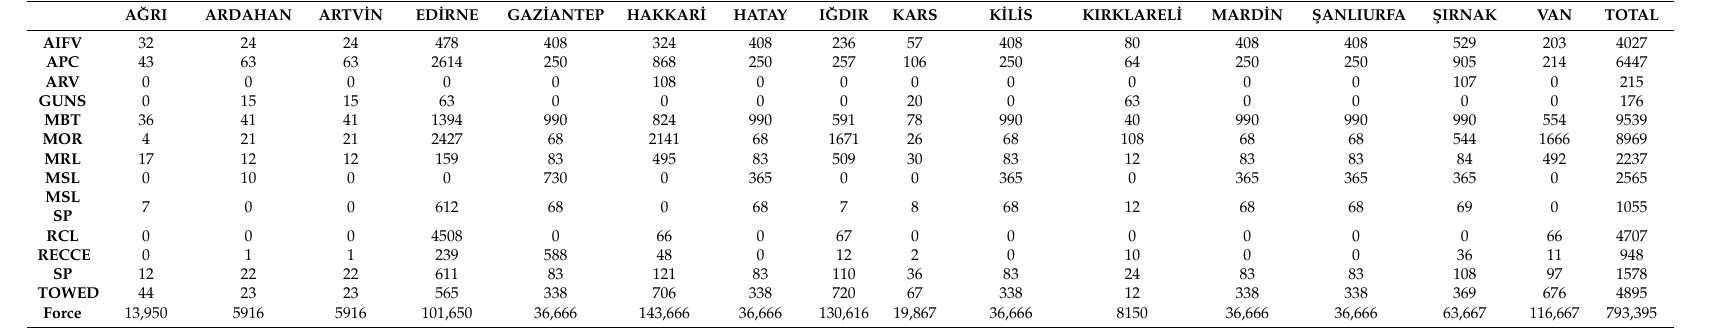
Table 3. The number of units demanded of each weapon type at each demand